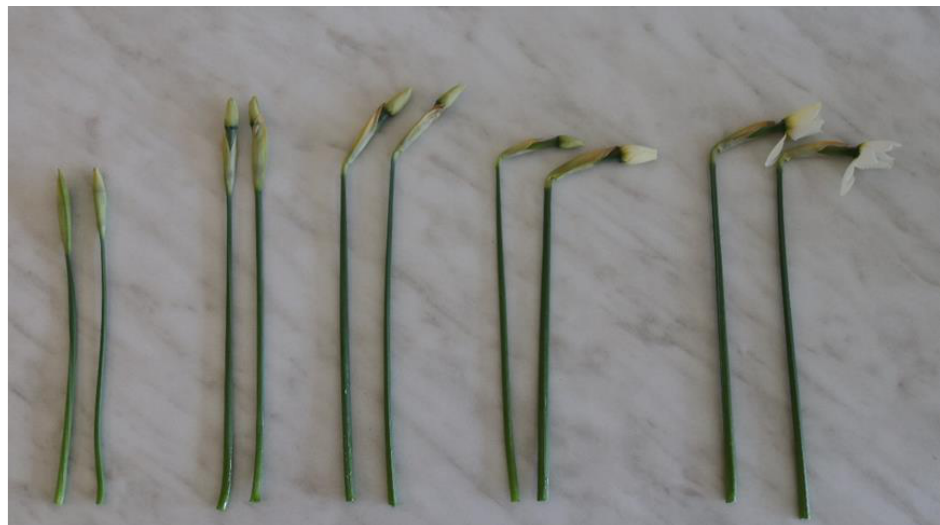
Figure 2. Initial bud stages (from left to right: green bud; pencil — white bud, upright; goose neck 1 — white bud, skew; goose neck 2 — white bud, horizontal; goose neck 3 — big white bud, horizontal, maximum with 1 opening petal).